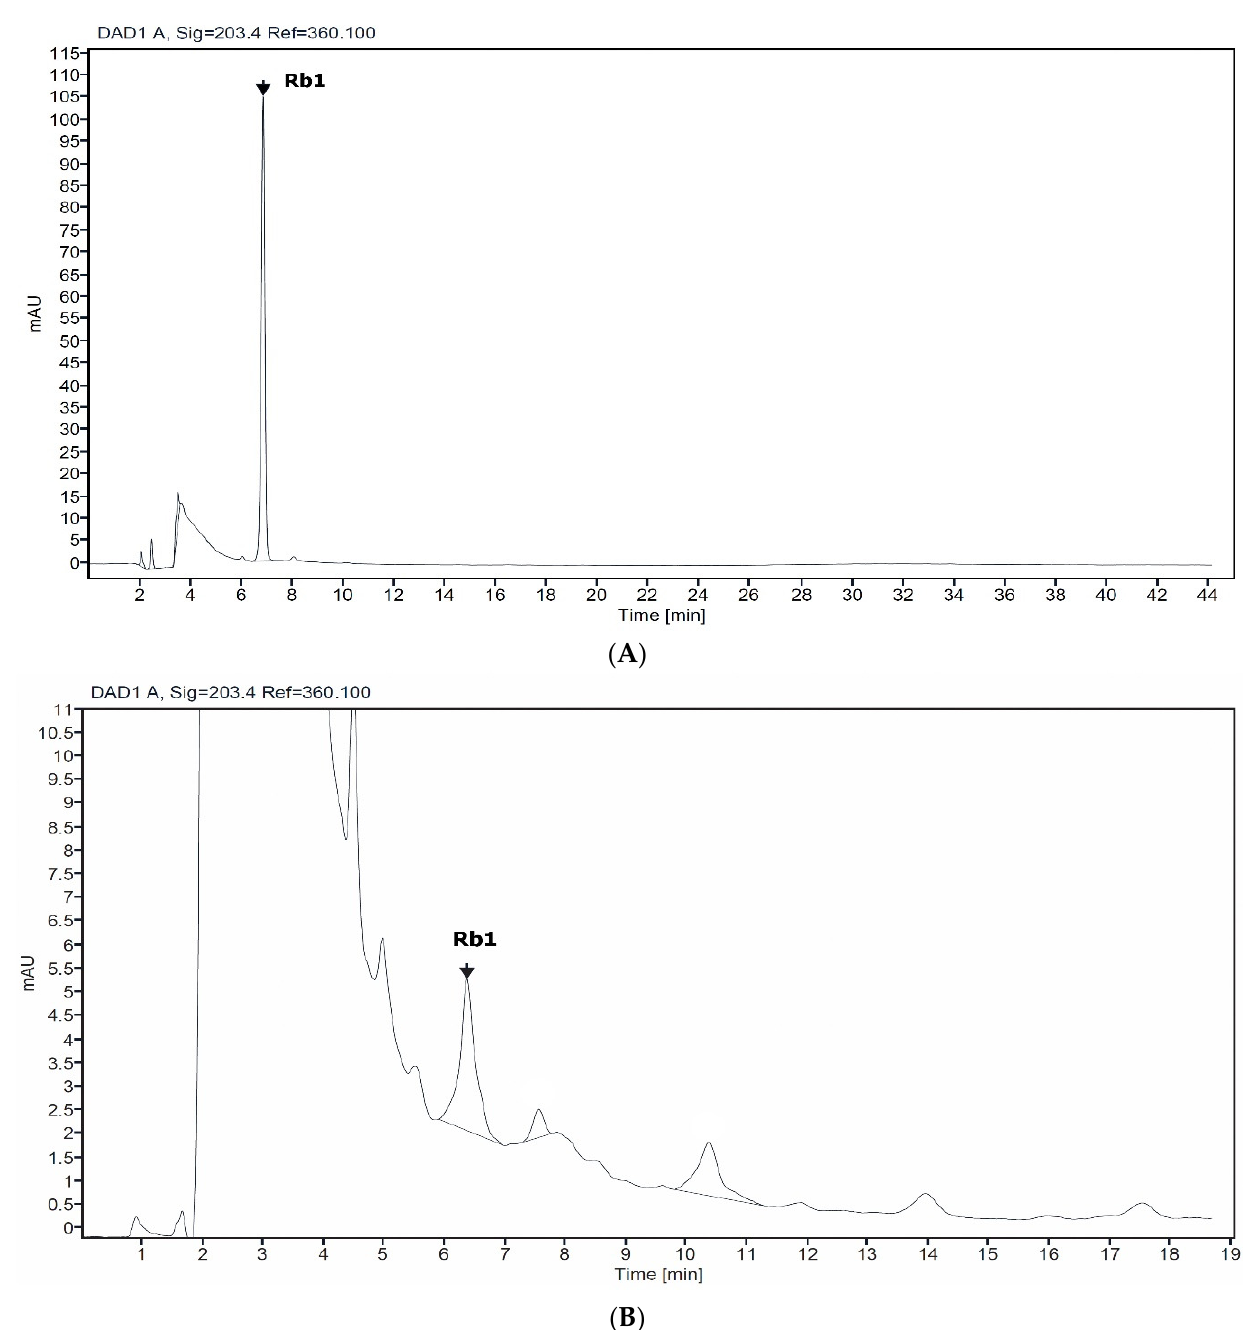
Figure 1. HPLC chromatogram profile of standard Rb1 ( A ) and suspension cell of giao co lam ( B ).